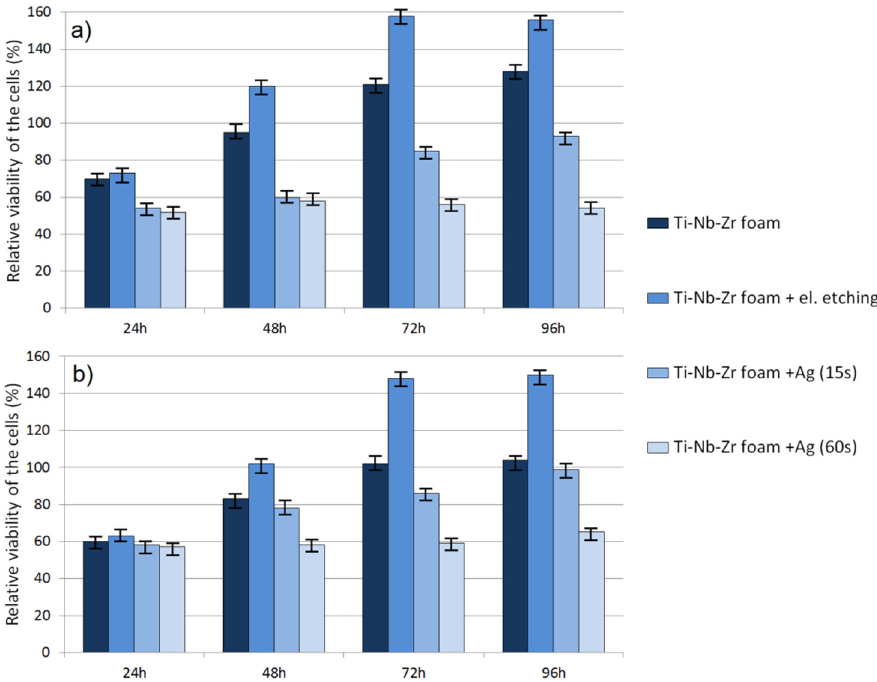
Figure 9. Results of the MTT assay performed at 24, 48, 72 and 96 h: ( a ) HPLF cells; ( b ) NHost cells.